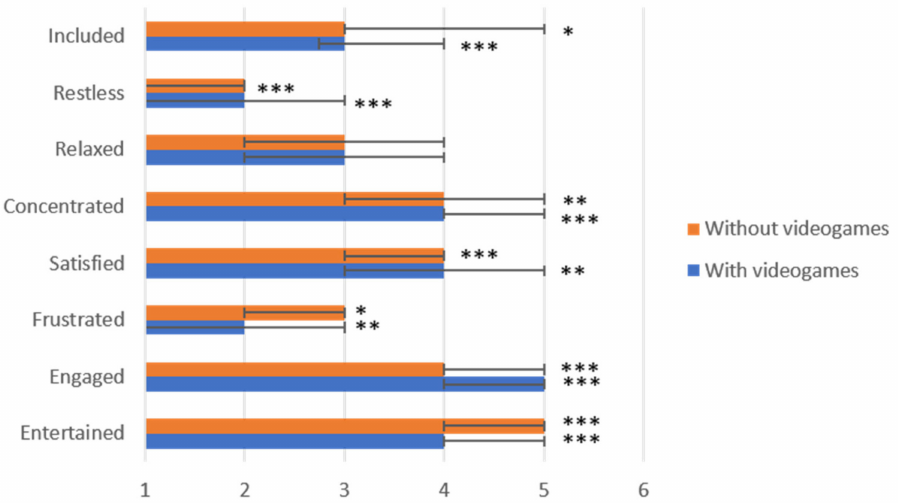
Figure 6. Children’s feelings when playing with and without videogames (blue and orange bars, respectively). Chi 2 test: * p < 0.05, ** p < 0.005, *** p < 0.0005. Null hypothesis: the scores referred